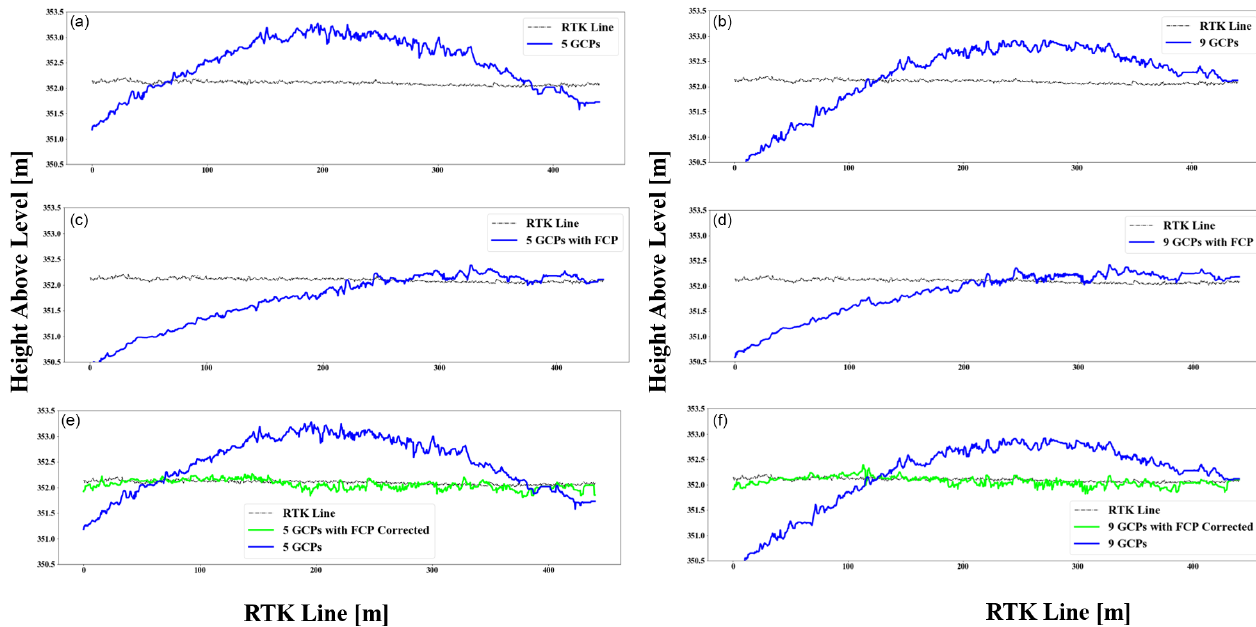
Figure B1. Correction for the doming